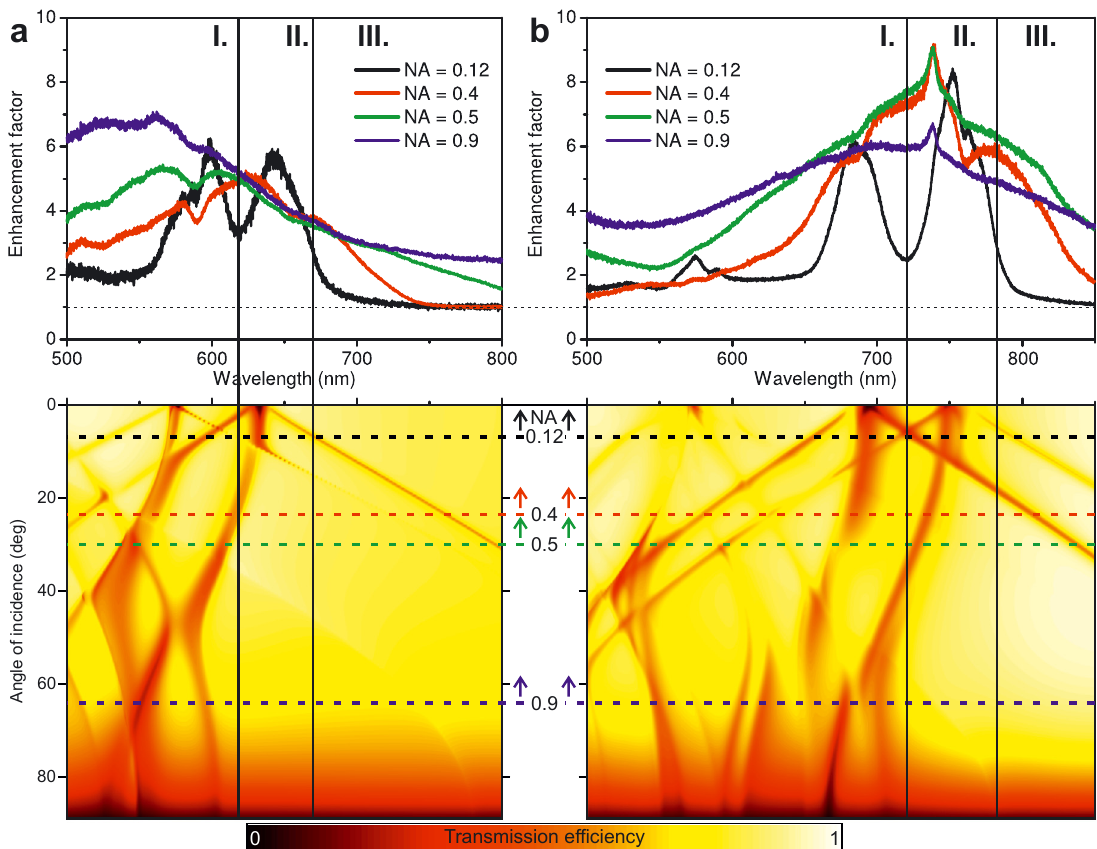
Figure 4: Top: Photoluminescence (PL) enhancement factor observed with microscope objectives with various numerical apertures (NAs) (a) before and (b) after the deposition of the tuning layer on the Photonic crystal (PhC) slab. Bottom: Simulated transmission spectra of the PhC slabs along the Γ – X direction for the corresponding spectral region. The horizontal dashed lines denote the maximum collection angle of the objective with speci fi ed NA. Vertical lines divide the spectra into three spectral regions that are discussed in the